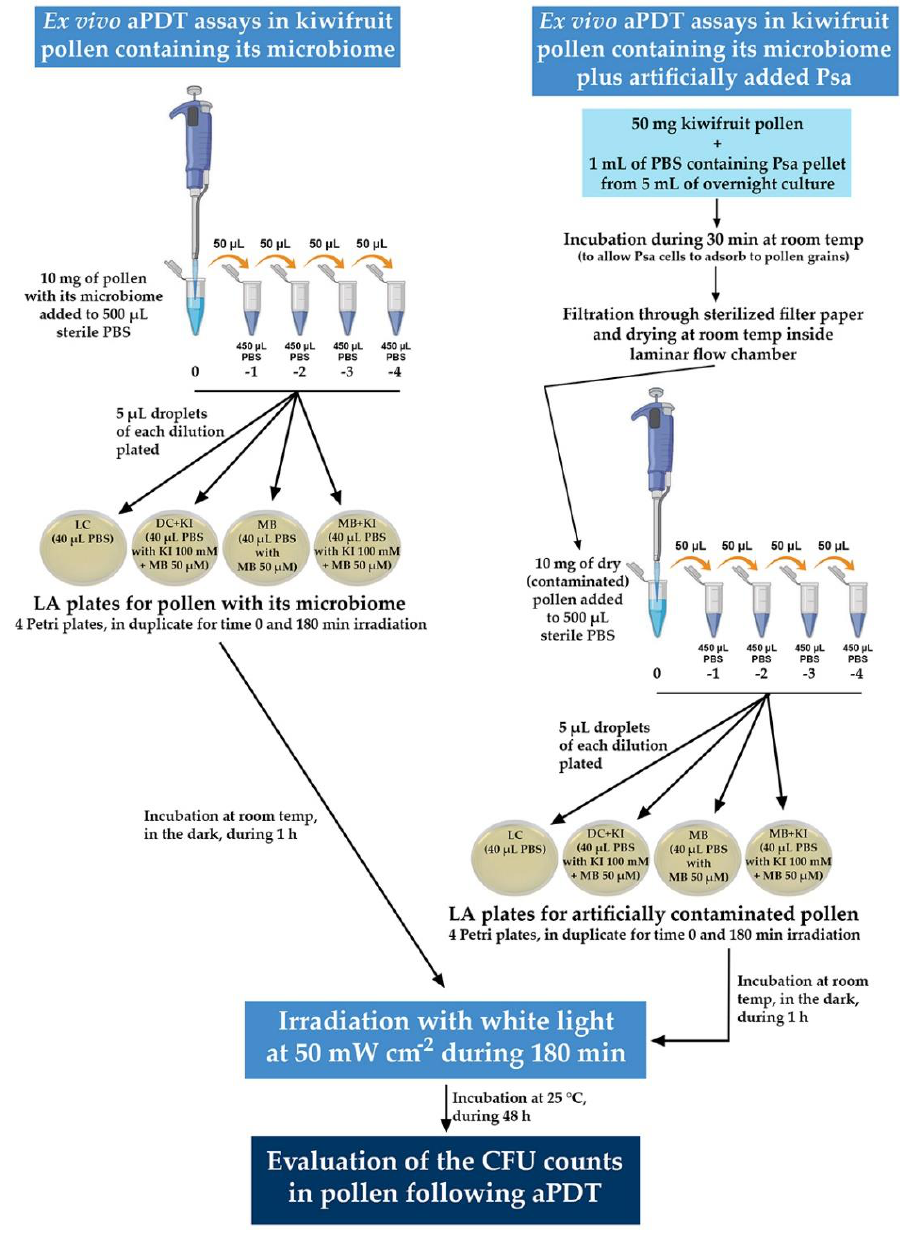
Figure 3. Schematic representation of the experimental procedure followed for the ex vivo aPDT assays. All the condition plates (LC, DC + KI, MB, and MB + KI) were made in duplicate to use one set for time 0 and the other set for time 180